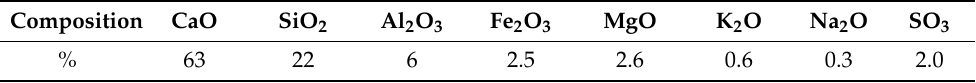
Table 2. Chemical composition of cement used (given by the fabricant).